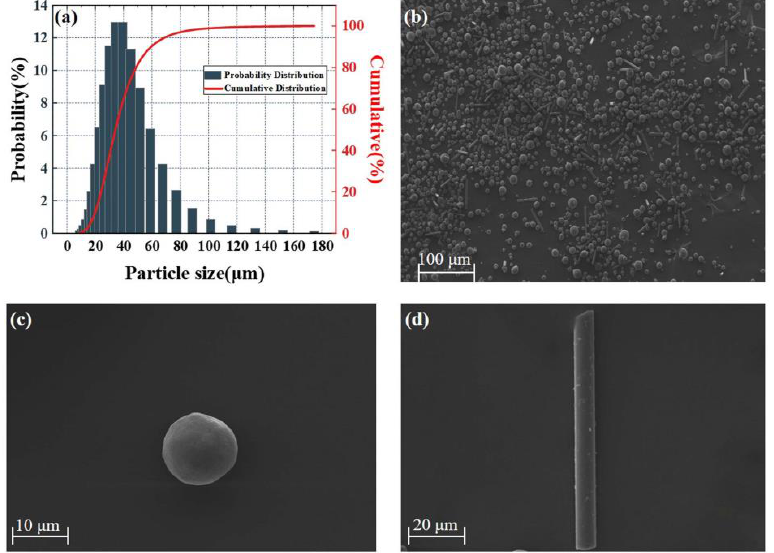
Figure 3. ( a ) Particle size distribution of aluminum powder; ( b ) SEM image of basalt–pure aluminum mixed powder; ( c ) single-particle Al particle; ( d ) single-particle basalt fiber.